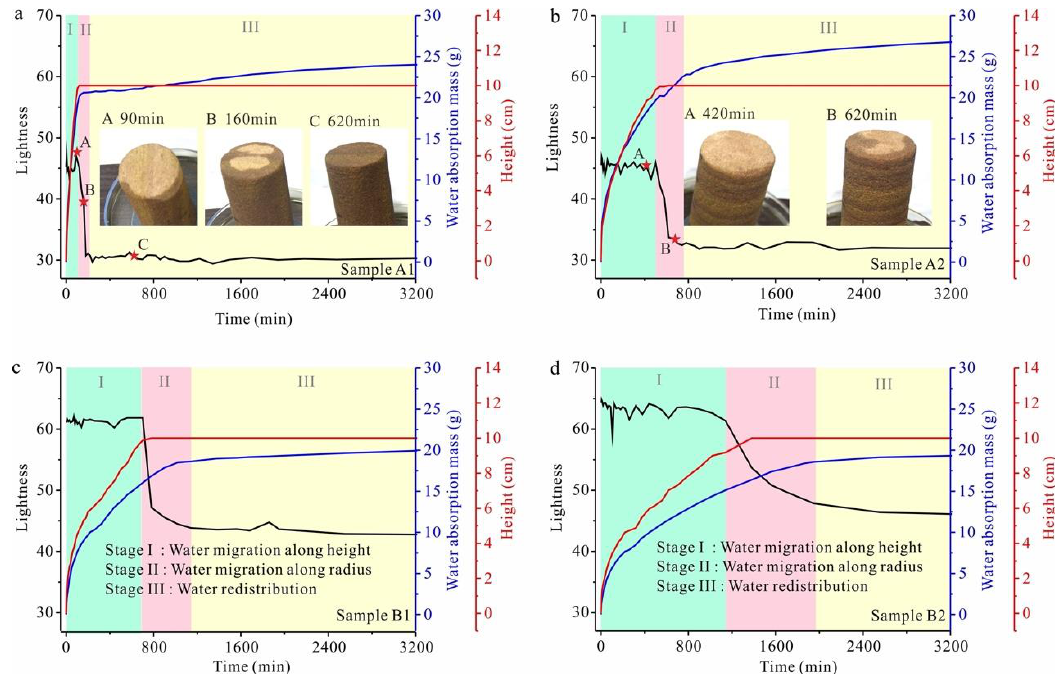
Figure 4. Lightness vs. time reflecting the water reaching the top surfaces in ( a ) Sample A1; ( b ) Sample A2; ( c ) Sample B1 and ( d ) Sample B2.